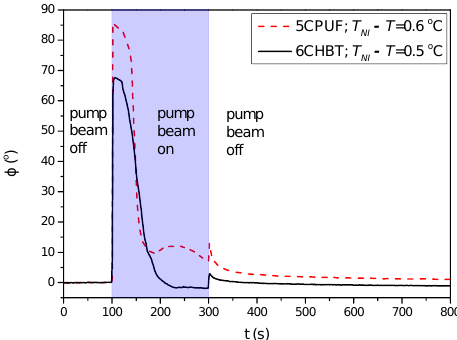
Figure 4. Temporal evolution of the azimuthal photoalignment angle ϕ measured for 5CPUF and 6CHBT at temperatures close to the phase transition temperature T NI